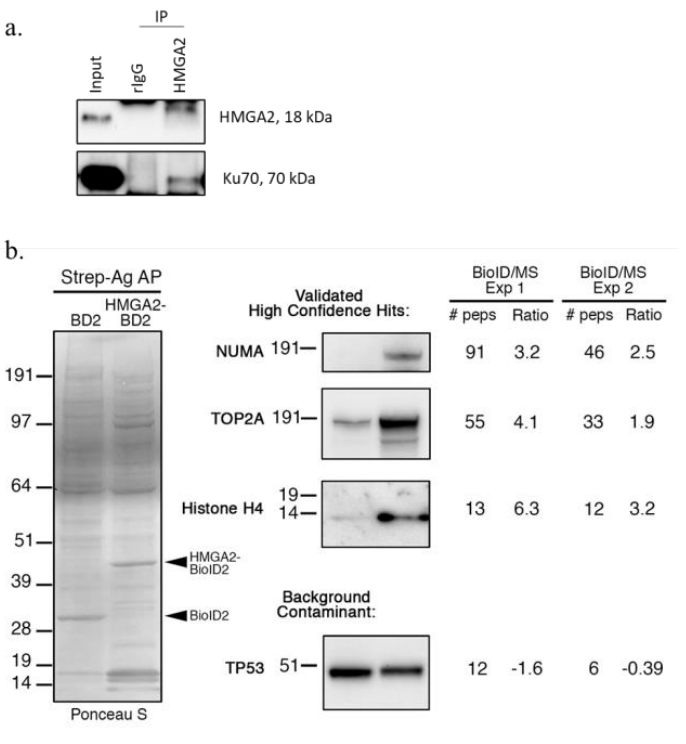
Figure 4. ( a , b ) Validation of candidate HMGA2 interaction partners. ( a ) Immunoprecipitation (IP) analysis of HMGA2 interaction with XRCC6 in MDA-MB-231 cells. Nuclear extracts were used for IP of HMGA2 with anti-HMGA2 antibodies. Rabbit IgG (rIgG) was used as a negative IP control. Immunoblotting confirmed co-precipitation of XRCC6 with HMGA2. ( b ) BioID/Western blot of analysis of proteins biotinylated by BioID2 alone (BD2) vs. BioID2-tagged HMGA2 (HMGA2-BD2) in the HEK293 stable cell lines in the presence of excess biotin for 18 h. Biotinylated proteins were captured on Streptavidin-agarose (Strep-Ag) beads (Thermo-Fisher, Waltham, MA, USA). Total proteins were first detected by Ponceau S staining of the membrane, and then NUMA (New England Biolabs, Ipswich, MA, USA), TOP2A (New England Biolabs, Ipswich, MA, USA), Histone H4 (Abcam, Waltham, MA, USA), and TP53 (Santa Cruz Biotechnologies Inc, Dallas, TX, USA) detected using antibodies raised against each protein. For each protein, the number of peptides detected (and log2 SILAC Ratio) in both BioID2 AP/MS experiments is indicated. TP53 was included as an example of a background contaminant (SILAC ratio ≤ 1:1) that is non-specifically biotinylated by both HMGA2- BioID2 and BioID2